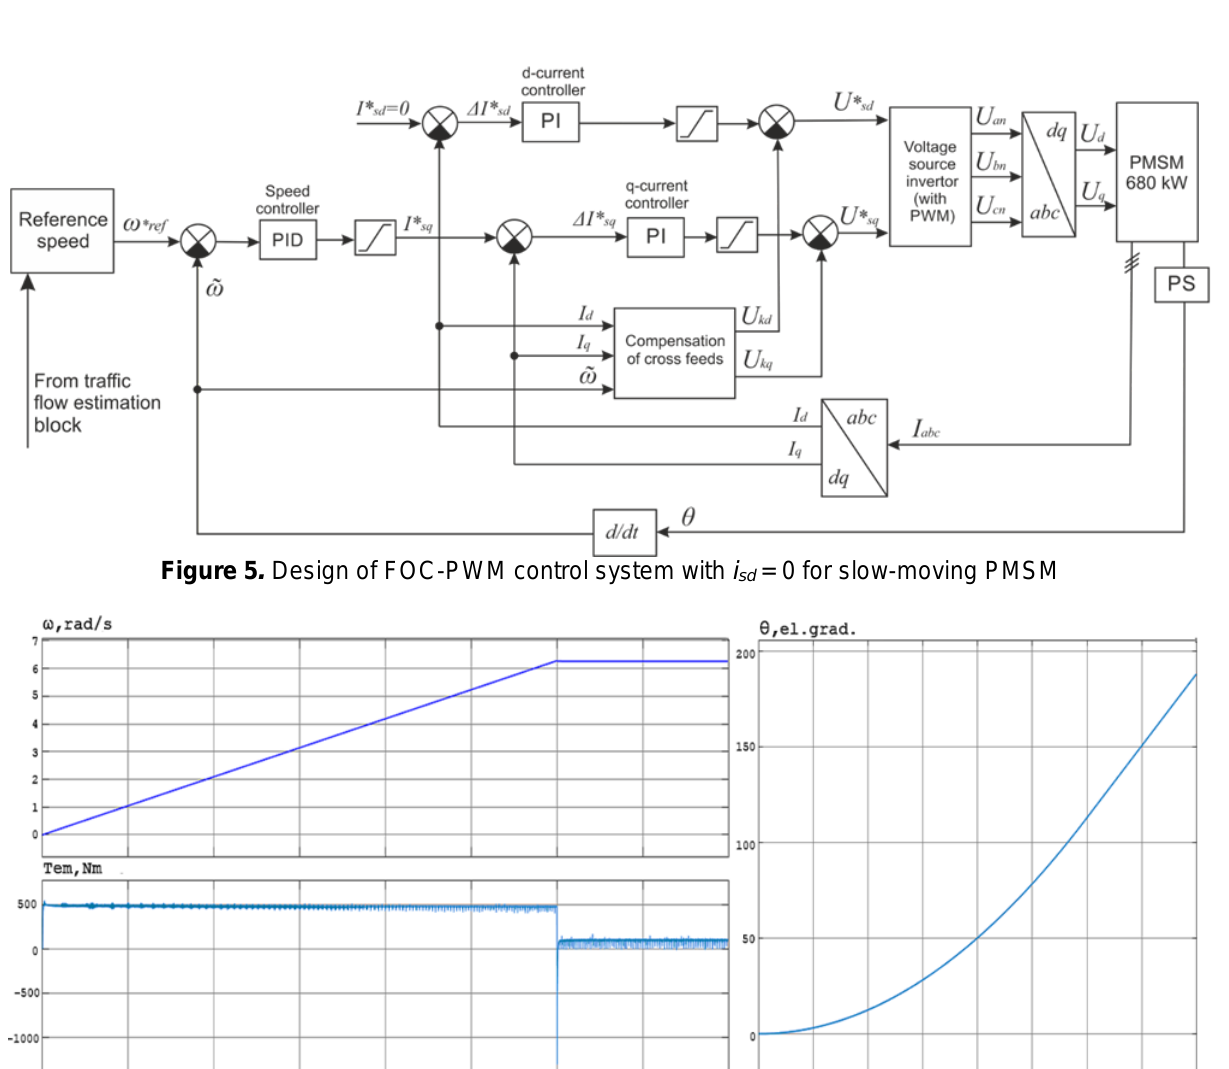
Figure 6 . Angle speed, electromagnetic torque, and rotor position angle versus time relationships (smooth starting time t = 3 s, T c = 100